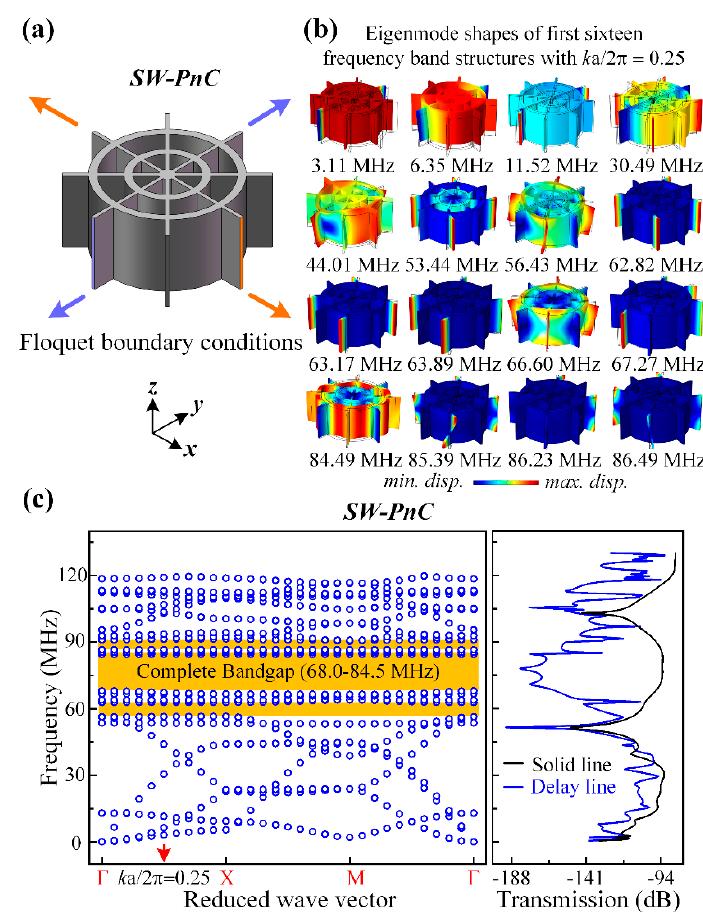
Figure 4. ( a ) 3D Illustration of the Floquet boundary conditions applied to a SW-PnC unit cell. Moreover, the boundary condition applied on the orange surfaces means an infinite number of repetitions in the x -direction, and the condition applied on the purple surfaces means an infinite number of repetitions in the y -direction. ( b ) Corresponding eigenmode shapes of the first 16 frequency band structures for the proposed SW-PnC with k a / 2 π = 0.25. ( c ) Band structures of an infinite PnC are consistent with the transmission characteristics through a finite number of PnC unit cells for SW-PnC . The SW-PnC shows three complete bandgaps, and the widest frequency range of them is from 68.0 to 84.5 MHz.